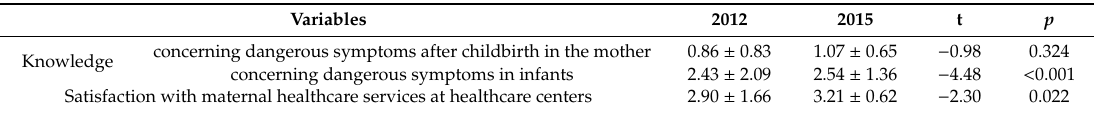
Table 3. Distribution of mothers’ knowledge of dangerous symptoms and satisfaction with maternal services at healthcare centers in 2012 and 2015 ( N =